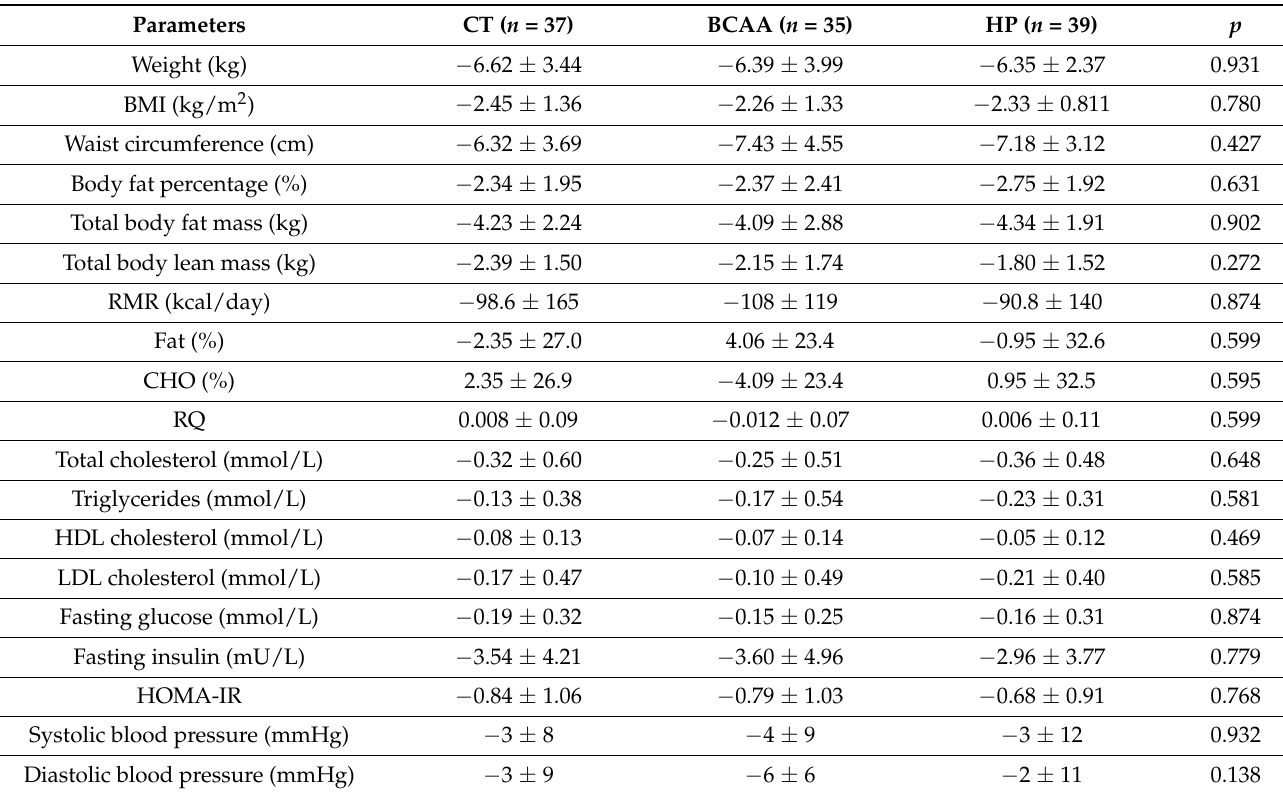
Table 1. Change in clinical parameters among study participants in the three diet groups after 16 weeks of weight loss